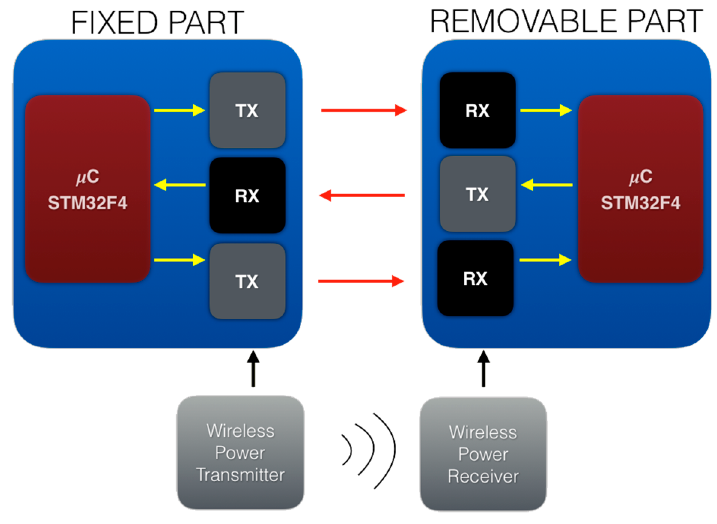
Figure 8. Block diagram of the new system.